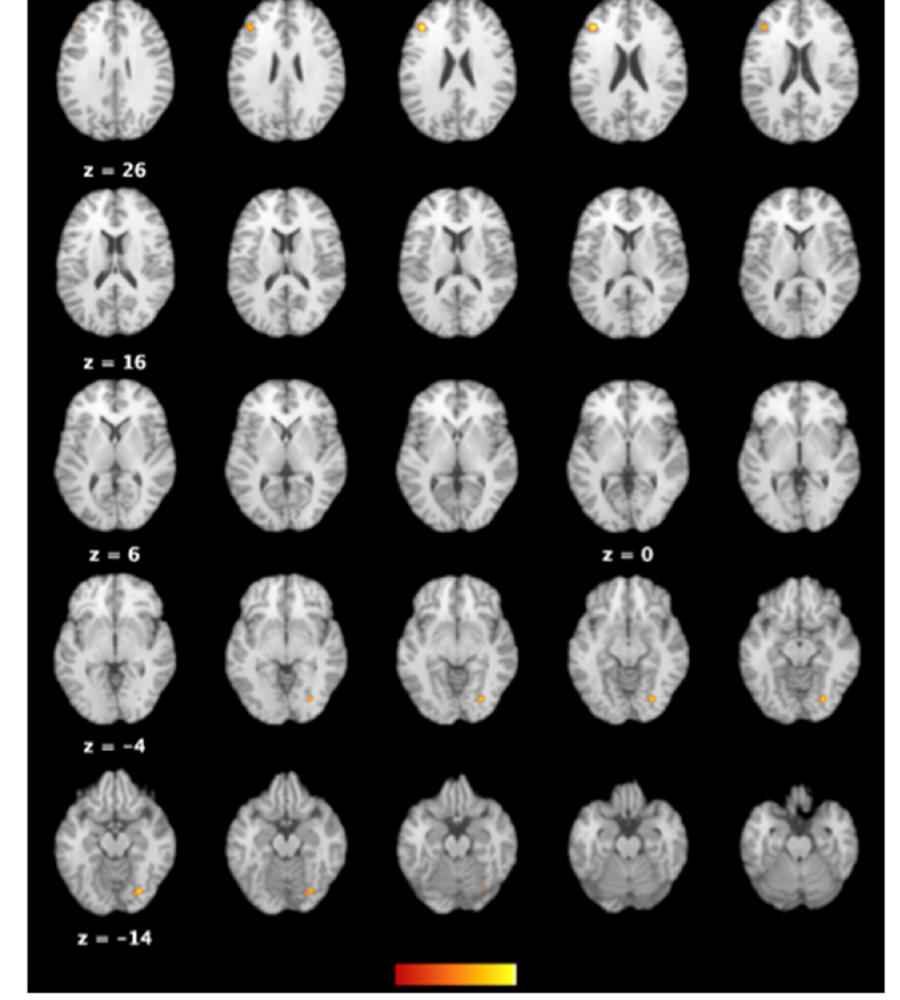
Figure 4. Functional magnetic resonance imaging (fMRI) studies showing brain regions with